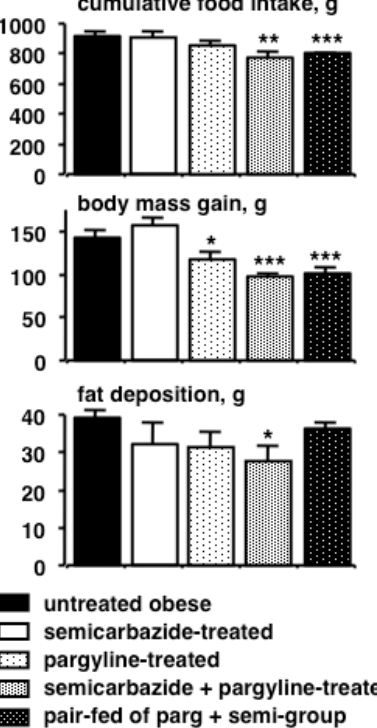
Figure 1. The anti-obesity effect of the combination of monamine oxidase and copper-containing amine oxidase inhibitors on weight gain and adiposity in obese Zucker rats. Nine-week old female obese rats were daily injected for 5 weeks with saline (untreated, dark column), semicarbazide (100 µ mol/kg body weight/day, open columns), pargyline (60 µ mol/kg/d, shaded columns) or their combination (semicarbazide + pargyline). A group of rats received the daily amount of chow consumed by the combination-treated group (pair-fed). At the end of treatment, the sum of inguinal + intra-abdominal adipose tissues removed from each rat was subtracted by 34.6 g, the equivalent mass found in the initial control group. Unpublished data given as mean ± standard error of the mean (S.E.M.) of five rats per group, for cumulative food intake, (upper graph), body mass gain (middle graph) and fat deposition (lower graph). Different from untreated at: * p <0.05, ** p <0.02, *** p <0.01.